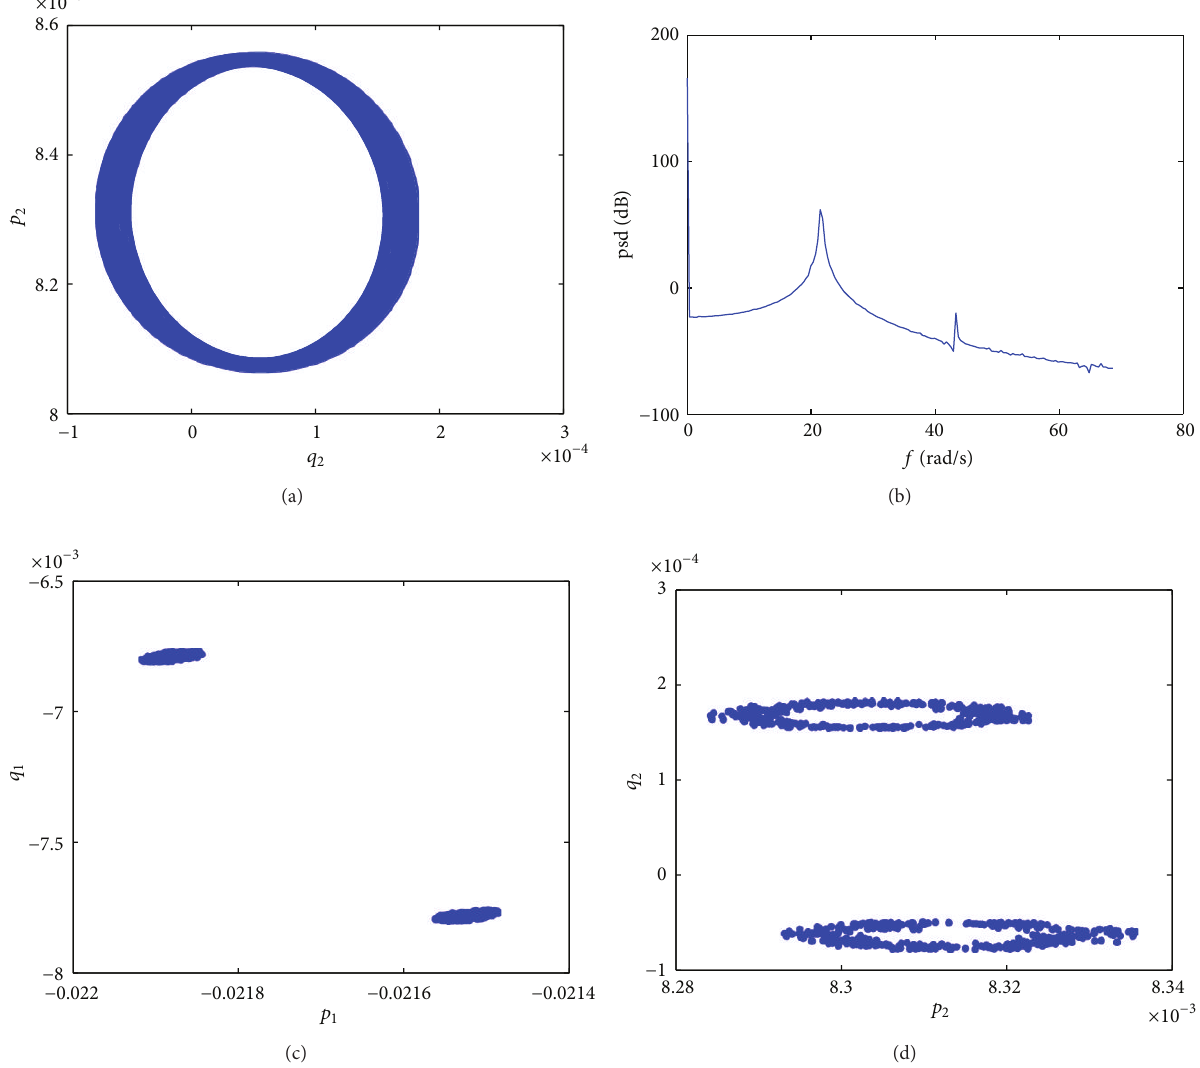
Figure 11: Phase portrait (a), FFT power spectra (b), and Poincare maps (c, d) for 𝜎 2 = 76.2799 , 𝜇 = 0.05 , V 1 = 10 , and 𝛼 = 0 , 𝜎 1 = 92.39